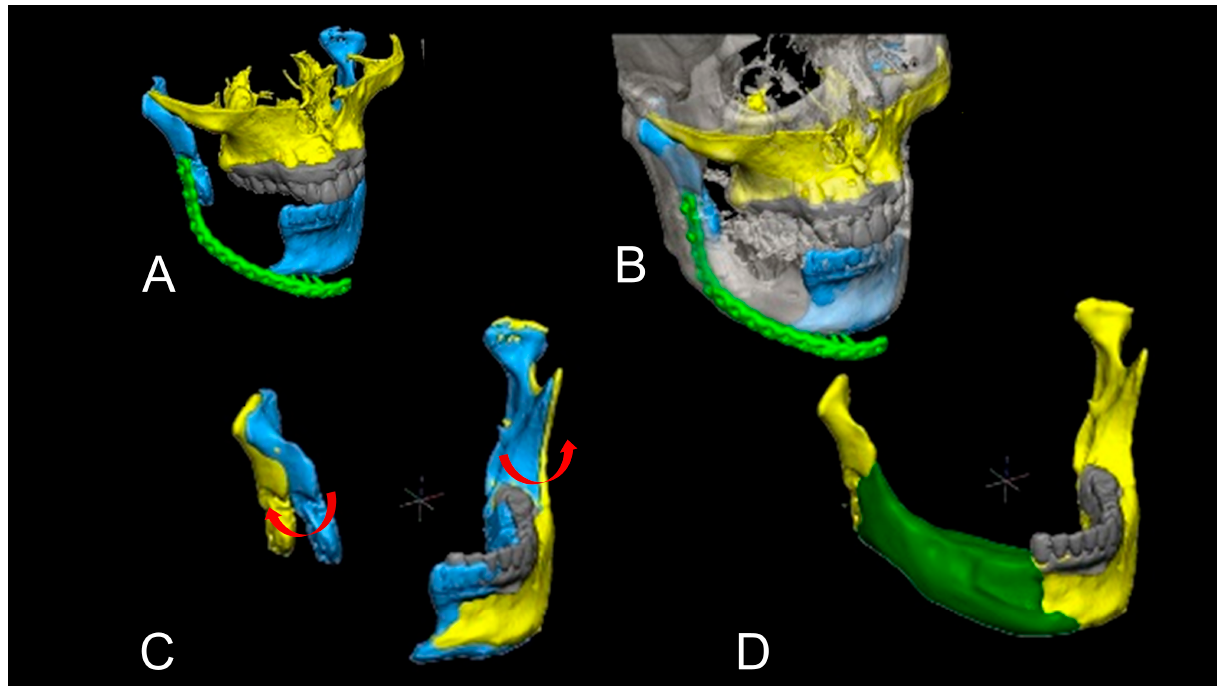
Figure 5. Simple mandibular deviation. This is a case of segmental mandibular defect due to ameloblastoma, and the mandible was reconstructed with a surgical plate simultaneously (Case 10). The plate was fractured, and then the right condyle and mandible were displaced ( A ). The blue mandible shows a medially deviated mandible on both sides. The yellow mandible is the ideally positioned mandible. The displaced condyle and remaining dentition were superimposed on preoperative mandible CT data. The grey mandible indicates the preoperative position of the mandibular condyle ( B ). Red arrows indicate the direction of the normal position ( C ). Thus, the exact mandibular morphology was reconstructed virtually and green indicates the bone graft ( D ). After this process, a 3D model and a positioning gauge were made.